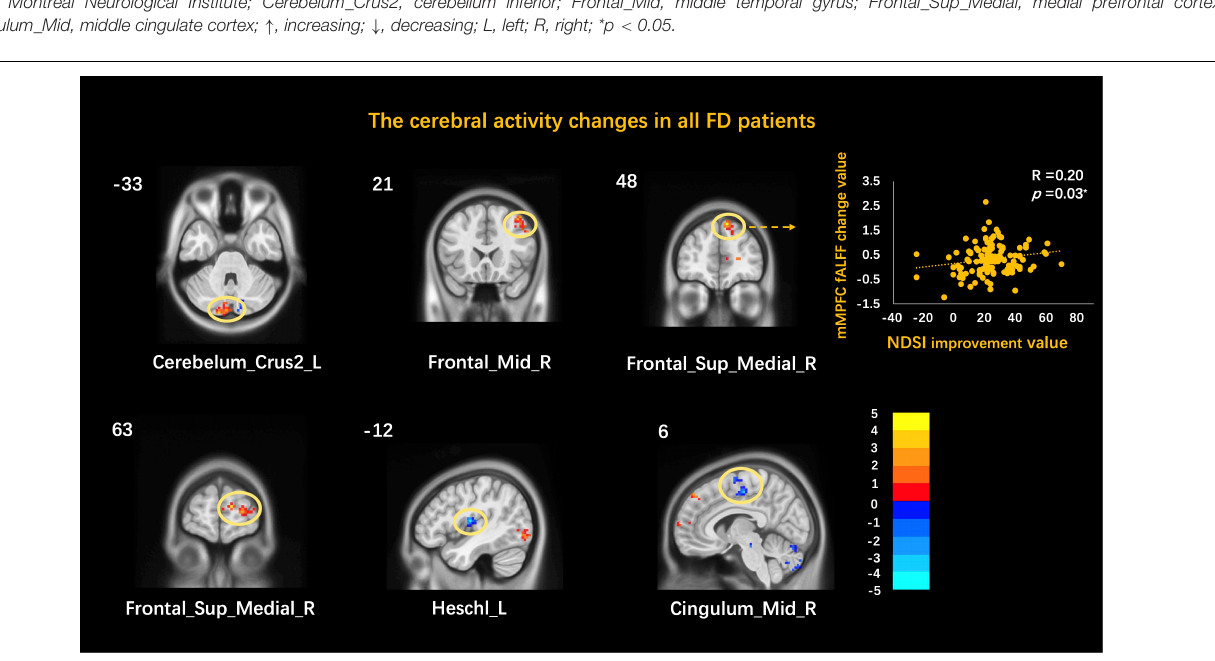
FIGURE 1 | Correlation between cerebral activity changes and symptom improvement. Cerebelum_Crus2, cerebellum inferior; Frontal_Mid, middle temporal gyrus; Frontal_Sup_Medial, medial prefrontal cortex; Cingulum_Mid, middle cingulate cortex; L, left; R, right; * p < 0.05. TABLE 2 | Demographic characteristics and clinical variables in all FD patients/higher/lower groups. All FD patients ( n = 115) Higher response group ( n =